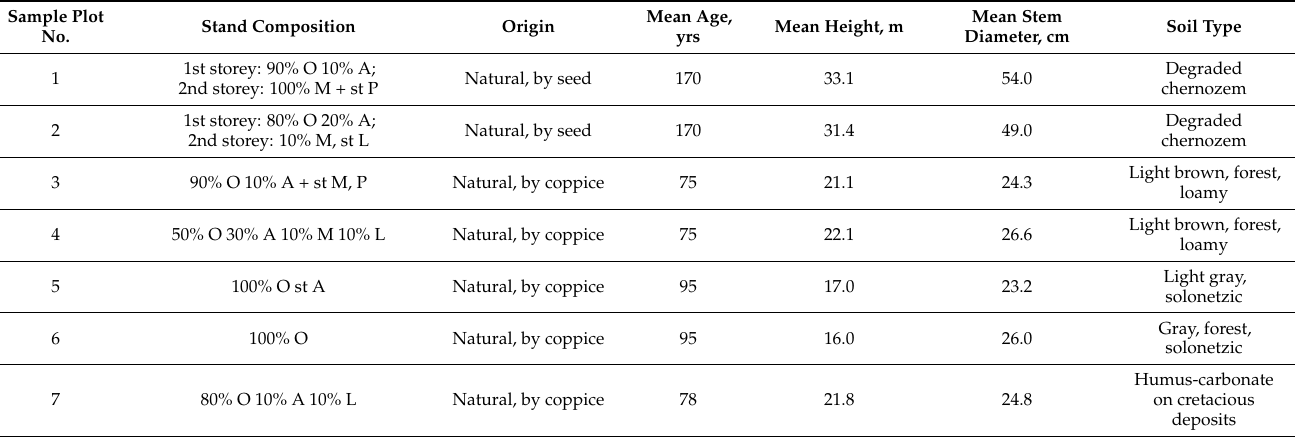
Table 1. Silvicultural characteristics of the forests.